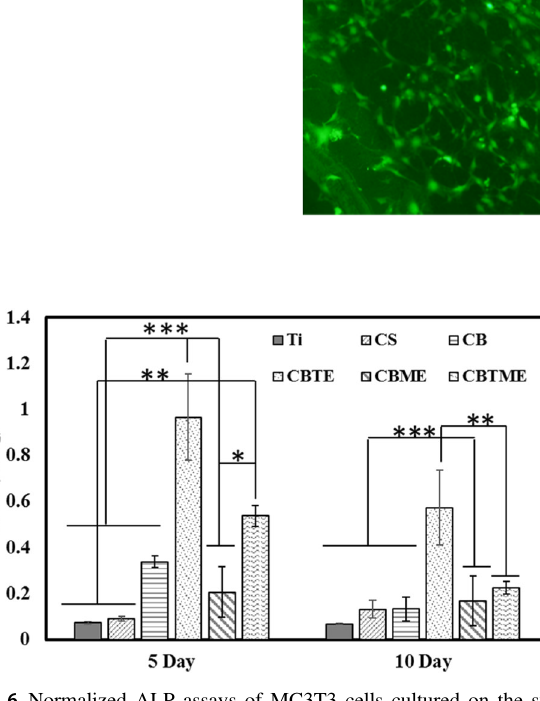
Fig. 6 Normalized ALP assays of MC3T3 cells cultured on the sur- faces after 5 and 10 days (* P < 0.05, ** P < 0.01, *** P <